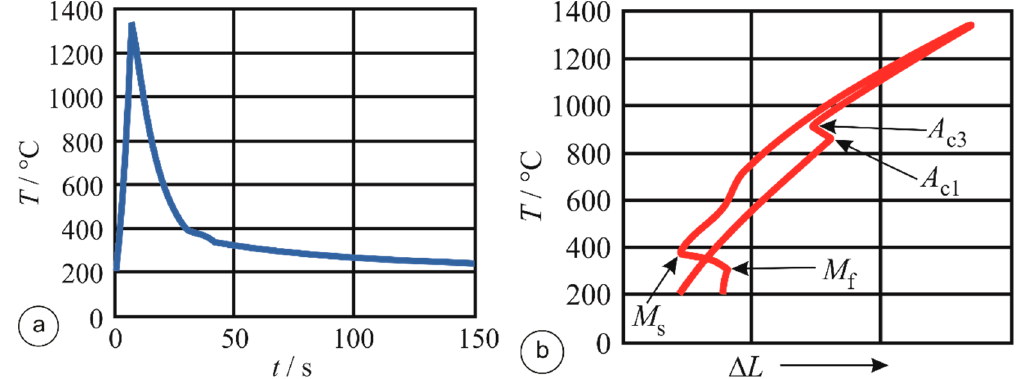
Figure 2. Characteristic ( a ) T-t and ( b ) T - Δ L curves for determination of transformation temperatures A C1 , A C3 , M s and M f .